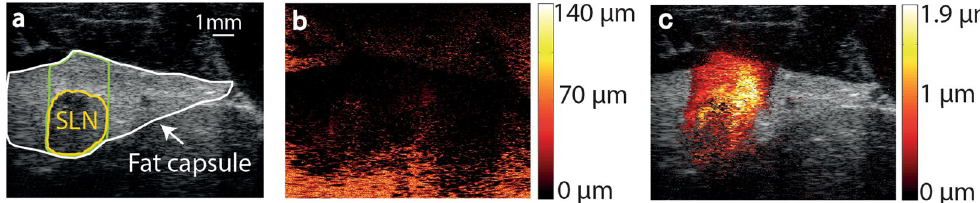
Figure 2. Images of the sentinel lymph node (SLN) and surrounding fat capsule in animal 5, obtained at an electromagnet excitation of 60 V at 5 Hz. ( a ) B-mode ultrasound image in which the SLN (yellow), the area where the magnetomotive ultrasound displacement was calculated (green), and the fat capsule (white) are outlined. ( b ) The total movement, i.e. the movement at all frequencies and phases, shown in colour-code for the area corresponding to that in the ultrasound image shown in panel A. The colour corresponds to displacement magnitude according to the colour-bar to the right. ( c ) MMUS image. In the image, displacement is only colour- coded when occurring with the same frequency and phase ( ± 0.35 radians) as the applied magnetic field. The colour-coded MMUS data is overlaid on the ultrasound B-mode image. Note that the maximum displacement magnitude is more than 70 times greater in panel ( b ) than panel ( c